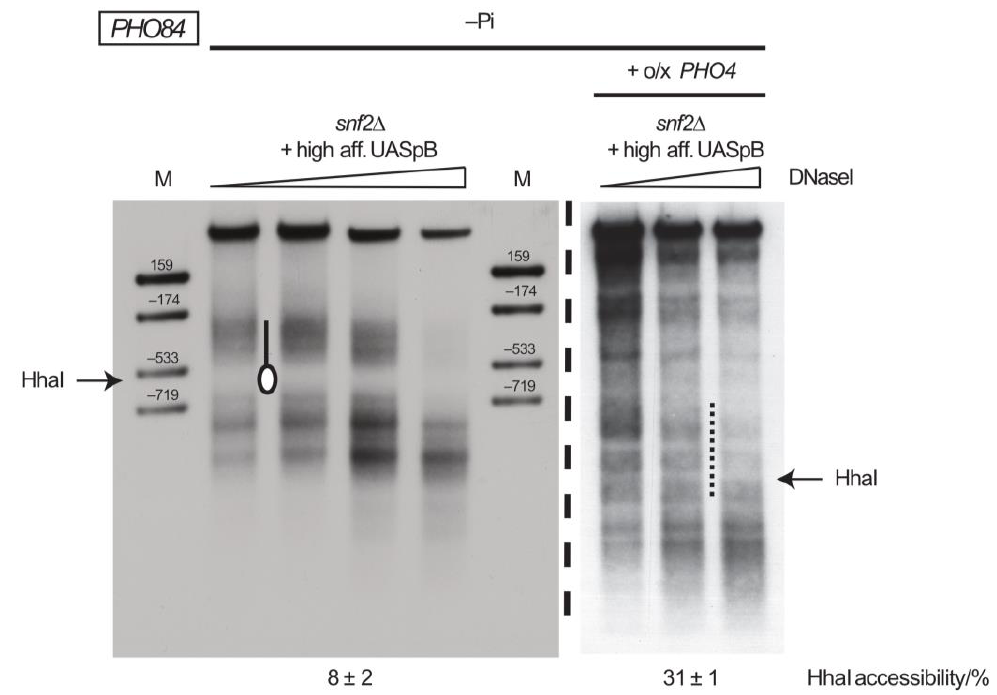
Figure 8. The combination of PHO4 overexpression with introduction of an additional intranucleosomal high-affinity Pho4 binding site (high-affinity UASpB) allows partial remodeling of the upstream nucleosome at the PHO84 promoter in the absence of SWI/SNF activity. DNaseI indirect end labeling for the plasmid PHO84 locus in snf2 ∆ cells (CY407) as in Figure 7B after overnight incubation in phosphate-free medium ( − P i ). “+ high aff. UASpB” corresponds to plasmid pCB84a-Bhi, where UASpB is mutated to a high-affinity UASp element according to Figure 7A. No marker for the plasmid locus was included in the gel on the right hand side, but the position of the HhaI site was estimated according to similar published gels (Figure 3B,C in ref. [42]). Even without exact cal- ibration of band gel positions it is clear that the protected region corresponding to the upstream nucleosome (see left hand side of figure) is not detected in the gel on the right hand side. Only the combination of the high-affinity UASpB site with PHO4 overexpression and – P i induction led to partial remodeling of the upstream nucleosome in the absence of SWI/SNF, as seen by 31 ± 1% HhaI accessibility and a DNaseI pattern in the region of the upstream nucleosome that resembled the open state (Figure 8, compare with the DNaseI pattern of the open state in wt under – P i conditions in Figure 7B). We concluded that PHO84 promoter upstream nucleosome remodeling depended more strictly on SWI/SNF than remodeling at the PHO8 promoter. Circumventing the SWI/SNF dependency at the PHO84 promoter required the combination of enhanced Pho4